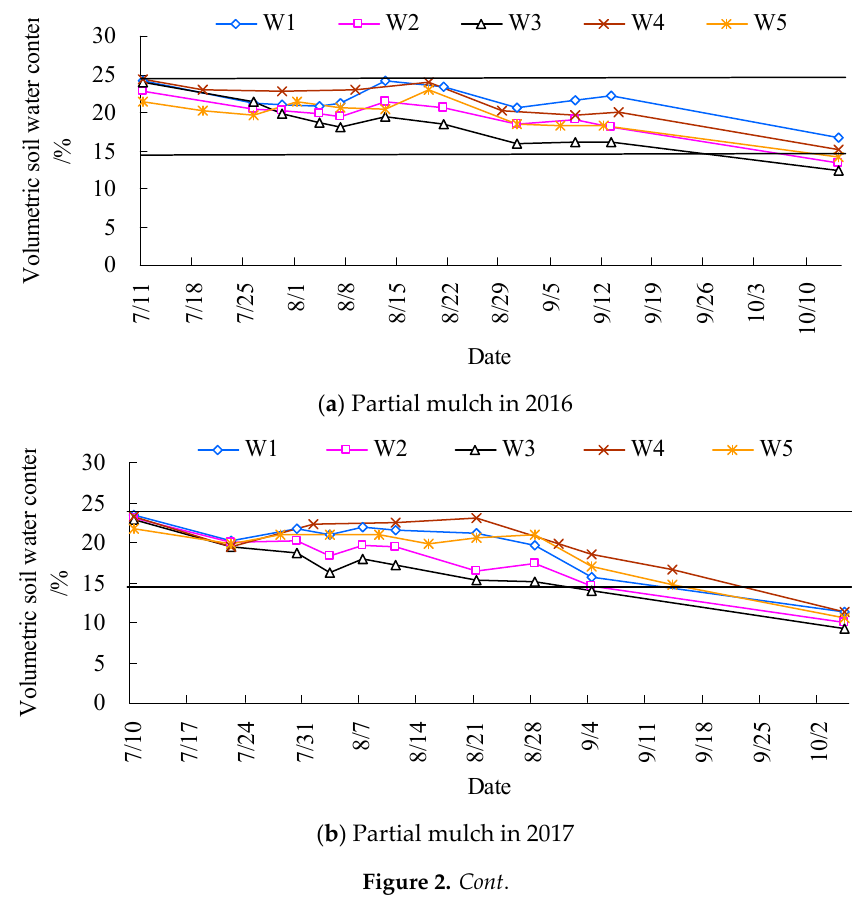
( b ) Partial mulch in 2017 Figure 2. Cont